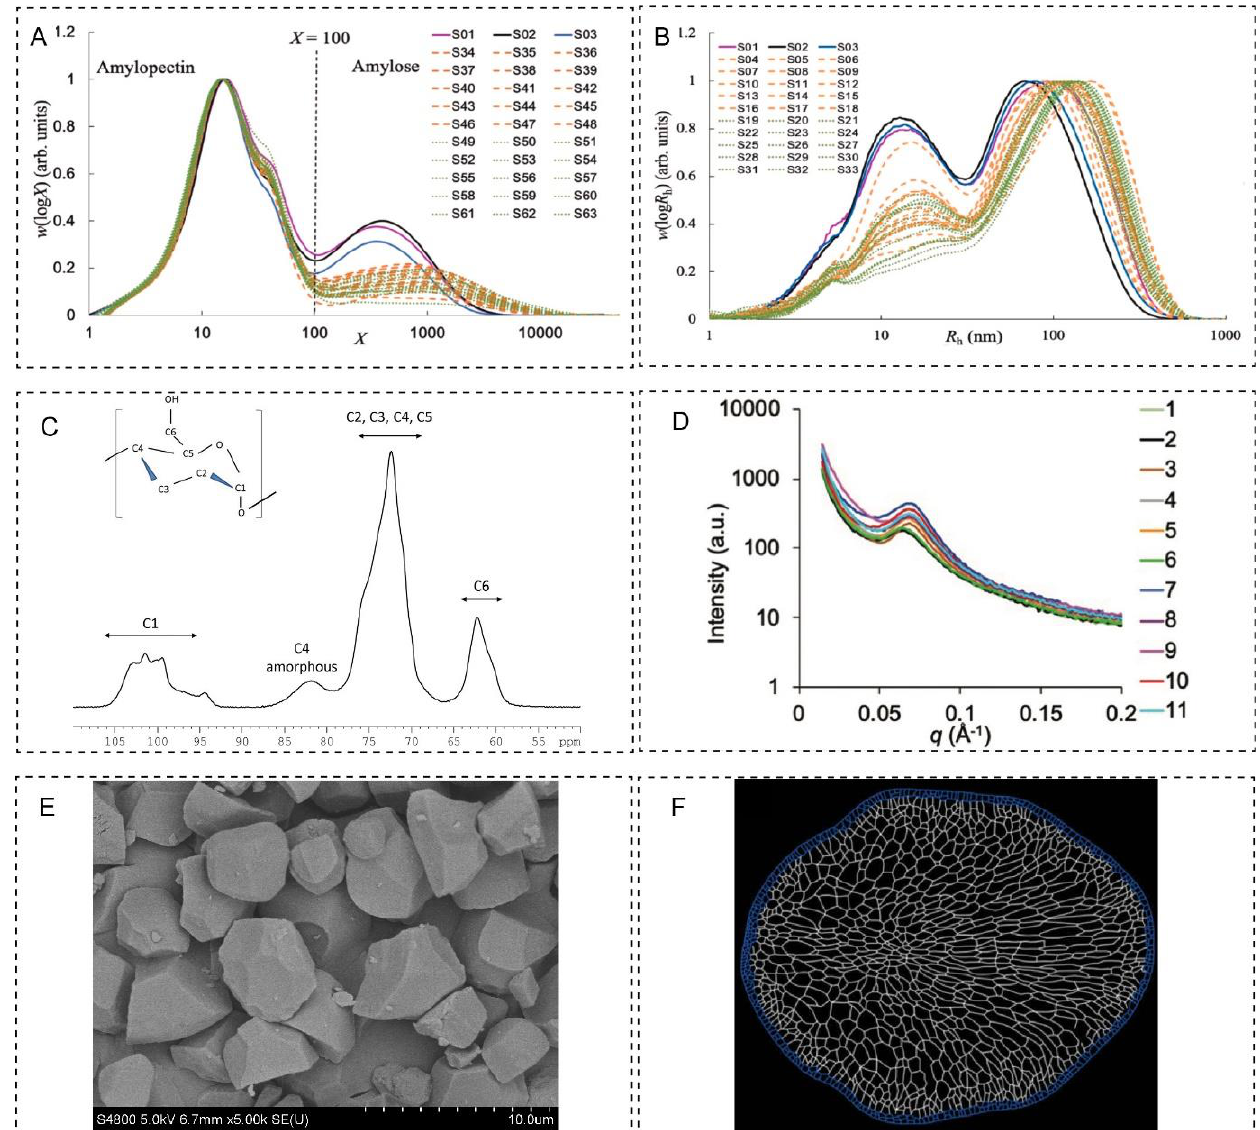
Figure 1. Different levels of rice starch structures. ( A ): level one; CLDs (obtained using SEC on Australian wild and domesticated rices). ( B ): level two; whole molecular size distributions (obtained using SEC on samples of Australian wild and domesticated rice). ( C ): level three; amylopectin double helices (from 13 C CP/MAS NMR spectrum of japonica rice). ( D ): level four; semi-crystalline growth rings (from small-angle X-ray scattering (SAXS) on wild-type rice varieties from China). ( E ): level five; granules ( E ) (for wild-type rice varieties from China, obtained by scanning electron microscopy). ( F ): level six; cellular structures (from an indica rice ( Oryza sativa L.) cultivar 9311, from light microscopy). Adapted with permission from Refs.